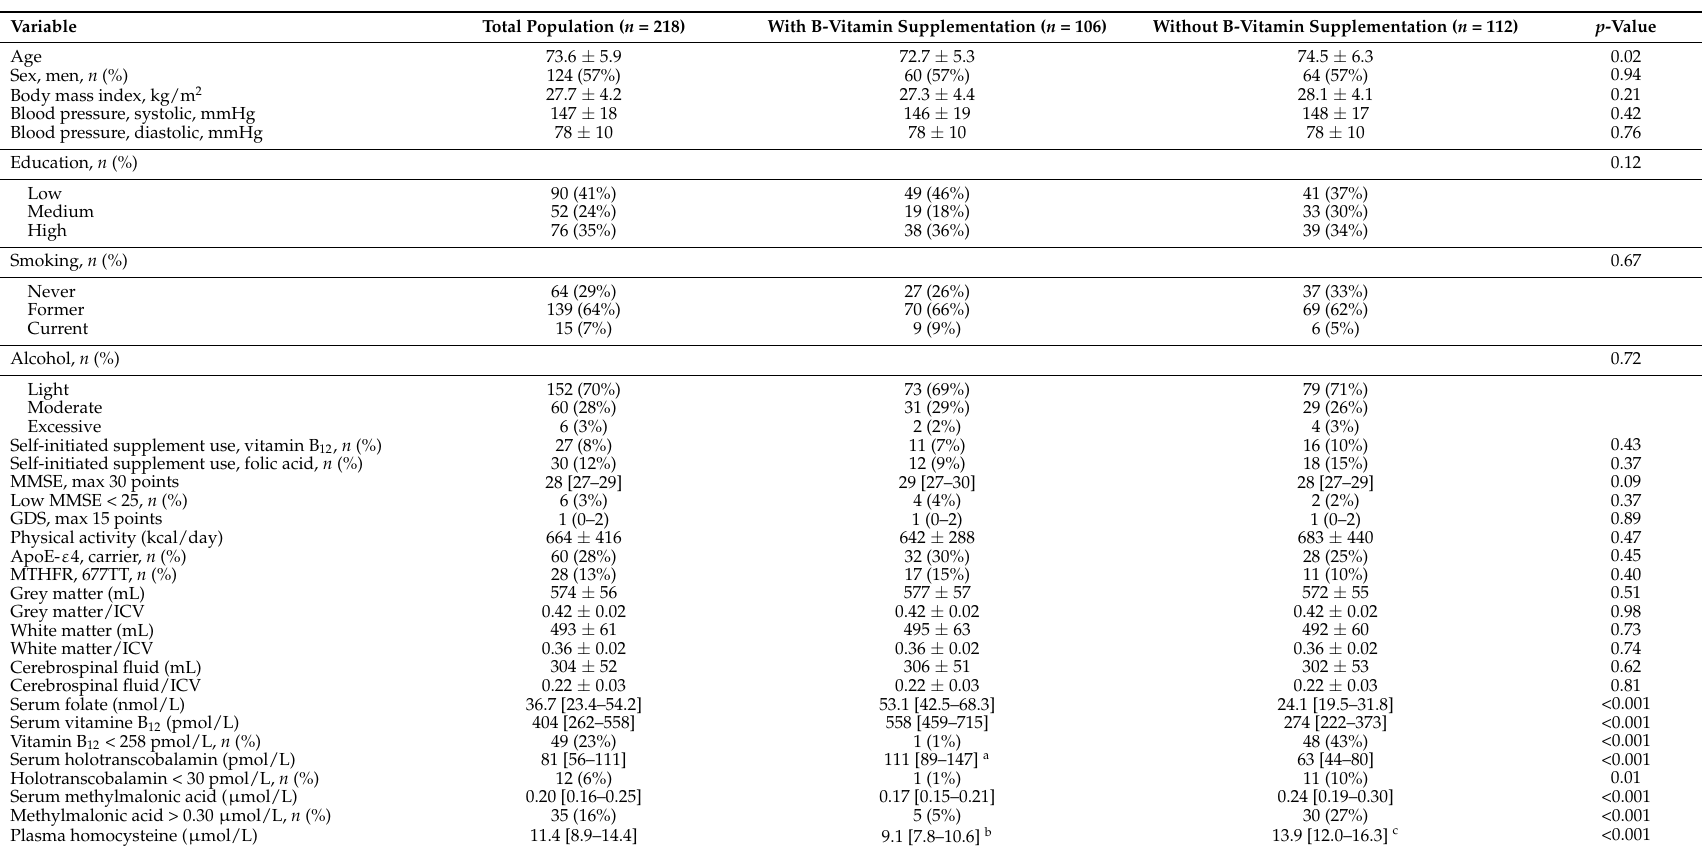
Table 1. Population characteristics at time of MRI measurements in participants who received two years of B-vitamin supplementation and participants who did not receive this